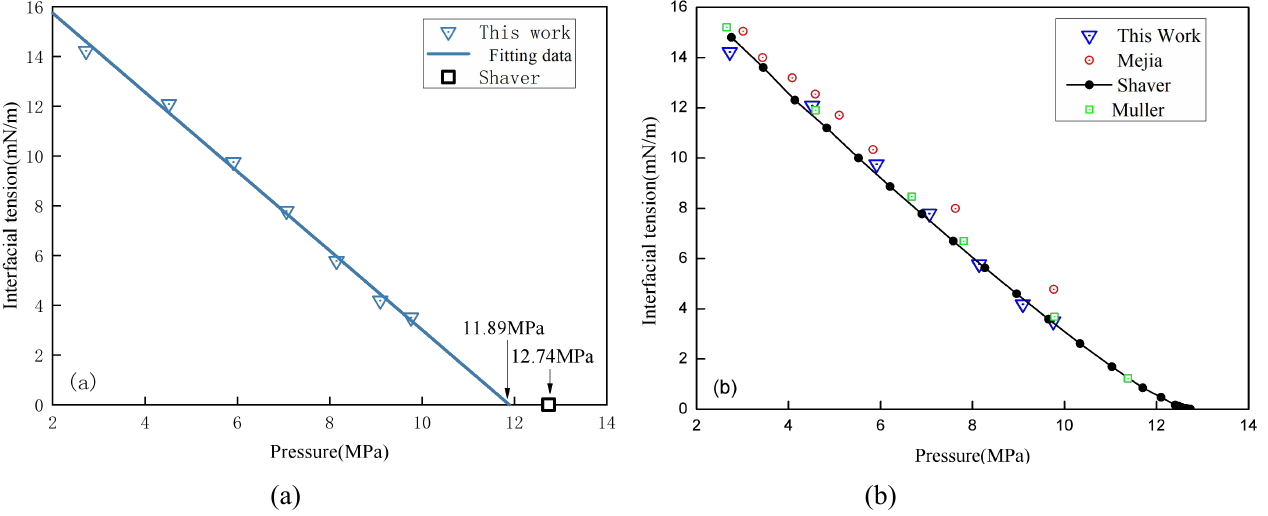
Figure 2 — Interfacial tension between carbon dioxide and n-decane with